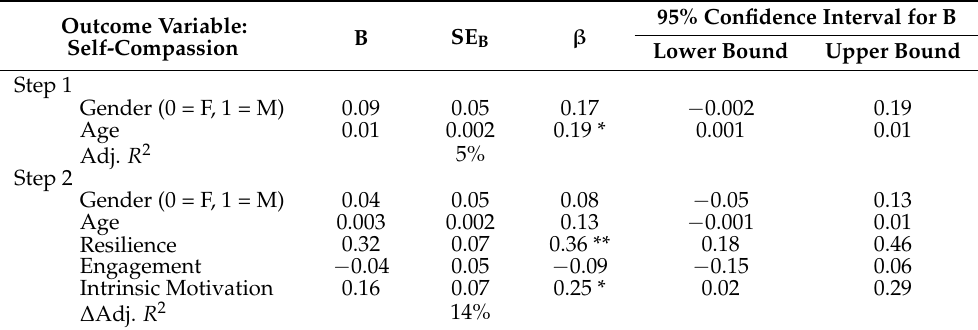
Table 3. Multiple regression: resilience, engagement and intrinsic motivation to self-compassion among social work students ( n = 129).